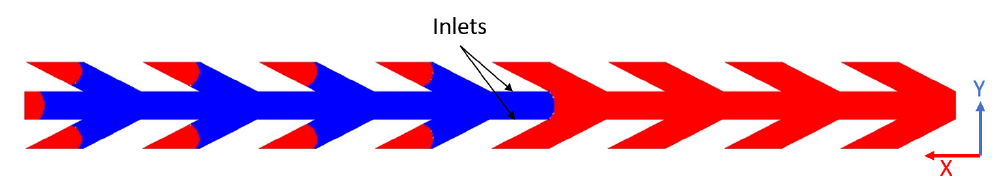
Figure 9. VOF two-dimensional simulation with θ = 50° and the geometry of the horizontal section of channel